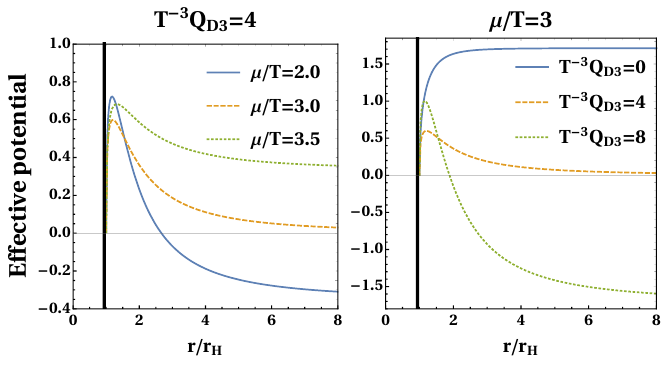
Figure 6 . The e(cid:11)ective potential for k = 0 and all charges equal, varying (cid:22)=T (left) and the angular momentum of the probe